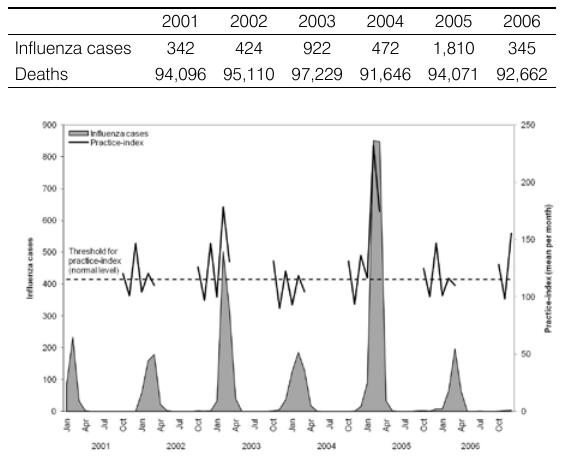
Figure 1. Influenza cases and practice-index for acute respiratory diseases in Baden-Wuerttemberg, Germany, 2001-2006.